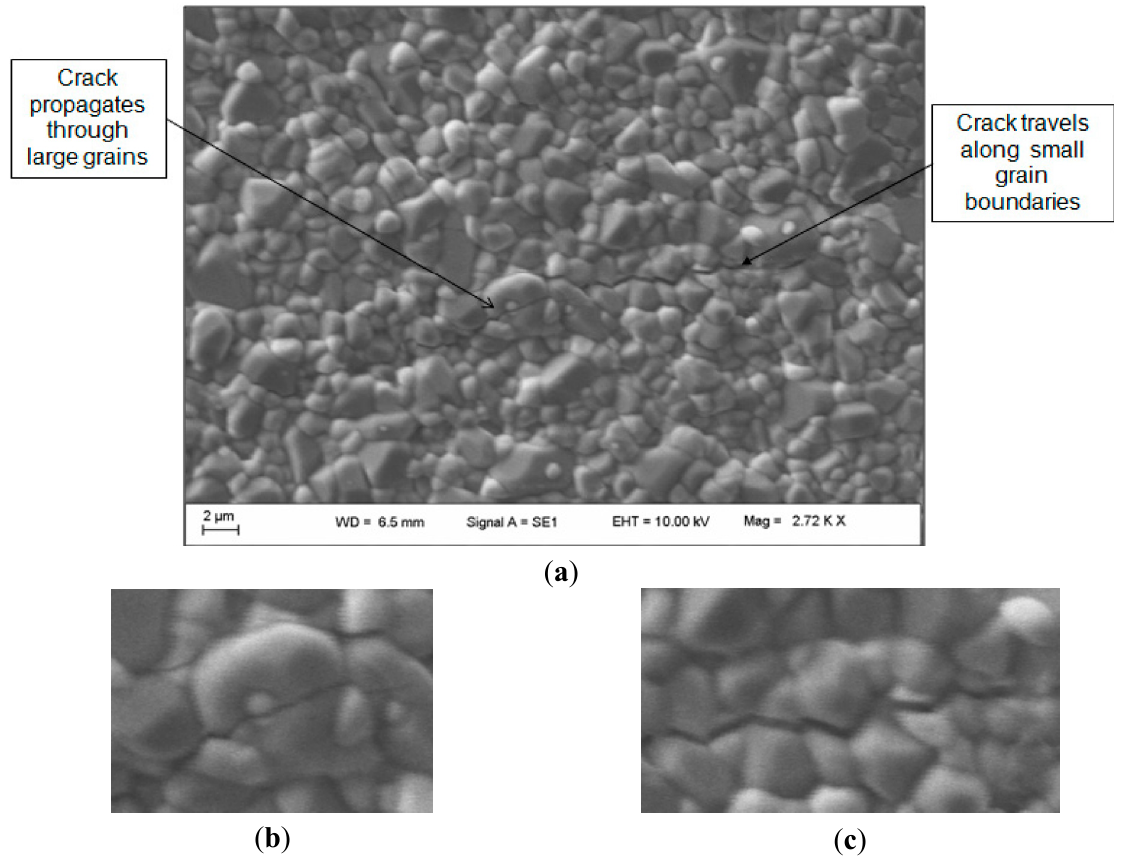
Figure 10. Scanning electron micrograph (SEM image) displaying ( a ) the nature of crack propagation in a ZTA ceramic in regards to small and large grain sizes where the crack travels; ( b ) through large grains; and ( c ) along the boundaries of small grains.